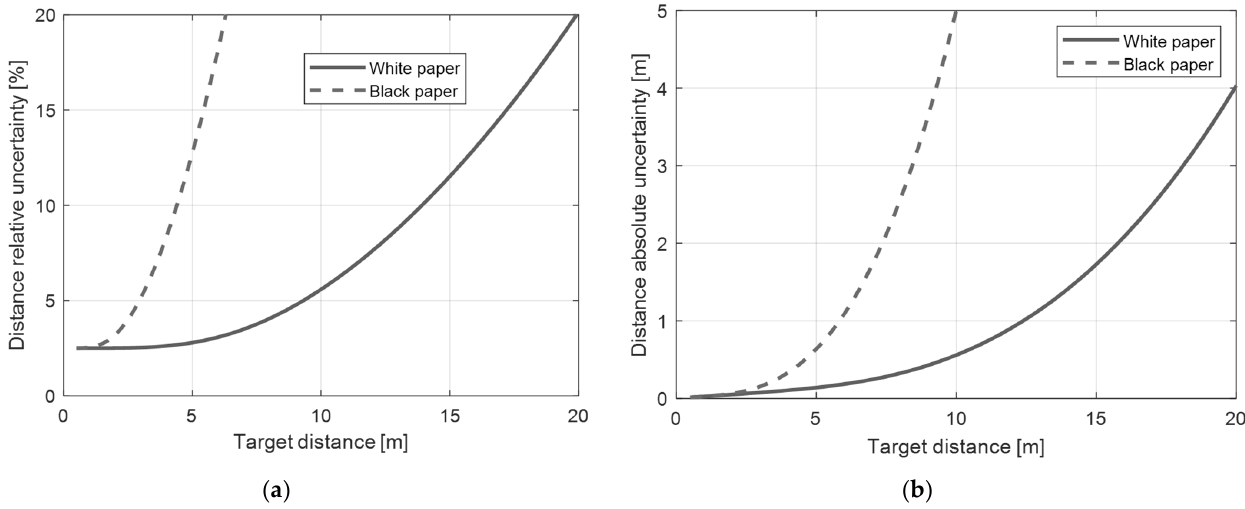
Figure 8. Estimated distance uncertainty as a function of target distance. (a ) Relative uncertainty and ( b ) absolute uncer- tainty.